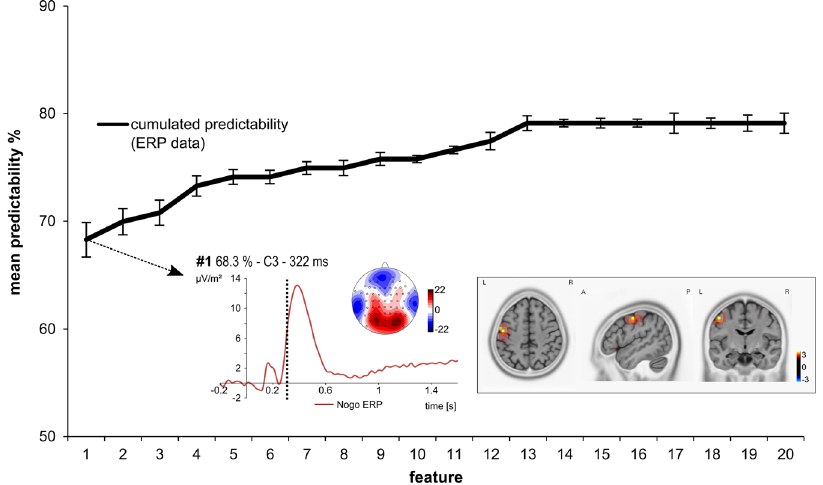
Figure 2. Results from the classification analysis using the time domain ERP data. The mean predictability is given depending on the number of features. The black curve in the figure shows the cumulative mean predictability. The error bars represent the 99% confidence level bounds. As can be seen the confidence bounds were overlapping for the first and the second feature. The ERP-curve of the first feature is also shown. The dashed vertical line in the plot shows the time point (feature) at electrode C3. The scalp topography plot reveals the distribution of voltages for this feature. The sLORETA plots (corrected for multiple comparisons using SnPM) show the source of the signal at the time point of the feature.